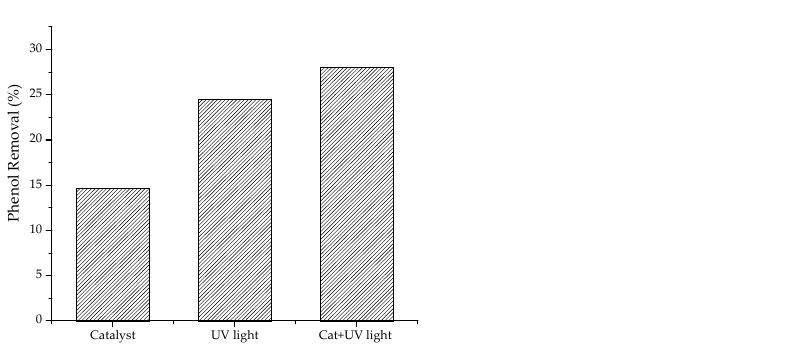
Figure 5. Comparative tests of adsorption (in dark, 0.0125 g of the NiNb catalyst, 25 mL of phenol solution in seawater, and pH = 3.5), photolysis (only UV-light for 1 h, without catalyst, 25 mL of phenol solution in seawater, and pH = 3.5), and heterogeneous-photocatalysis (0.0125 g of the NiNb catalyst + UV light for 1 h, 25 mL of phenol solution in seawater, and pH = 3.5).